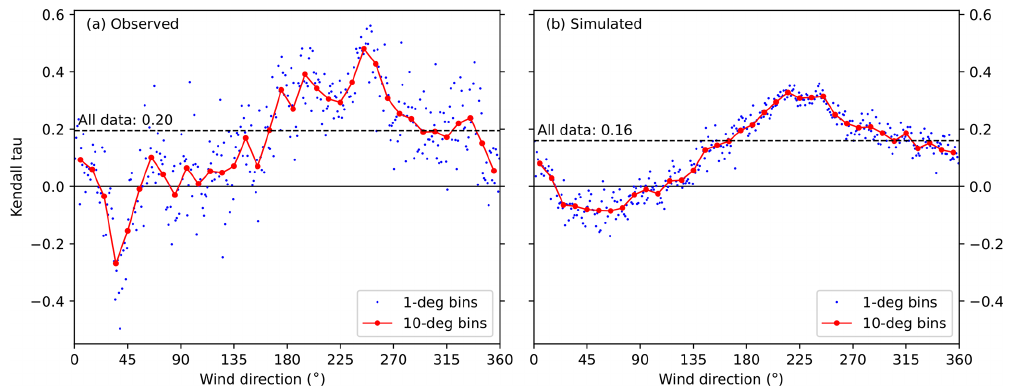
Figure 5. The Kendall correlation coefficients ( τ ) between significant wave height and sea level for different wind directions. The blue dots show correlation in 1 ◦ direction bins, and the red dots in 10 ◦ bins. The significant wave heights from (a) buoy observations during 2016–2019 and (b) simulated data set F during 1992–2019 are shown. The direction given is the direction from where the wind blows (nautical con- vention), observed at Harmaja weather station. The correlation coefficients for all data ( τ = 0 . 20 and 0.16; Table 2) are shown as horizontal lines.